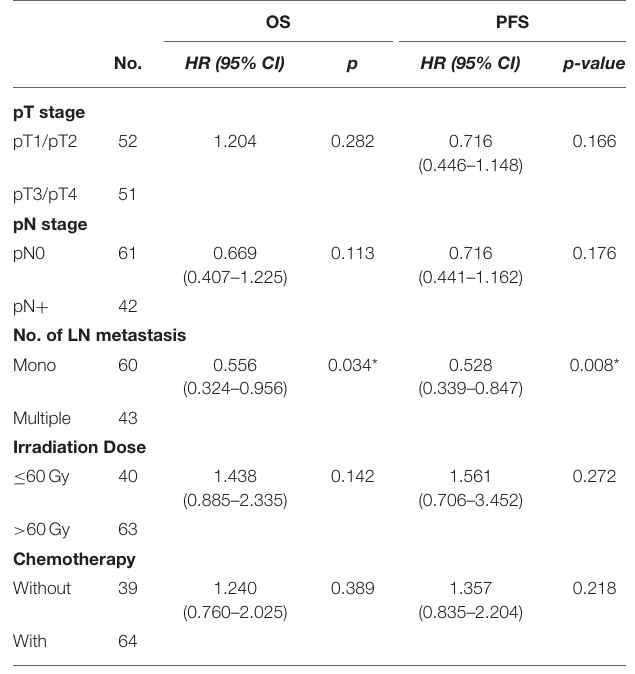
TABLE 2 | Multivariate analyses for OS and PFS.